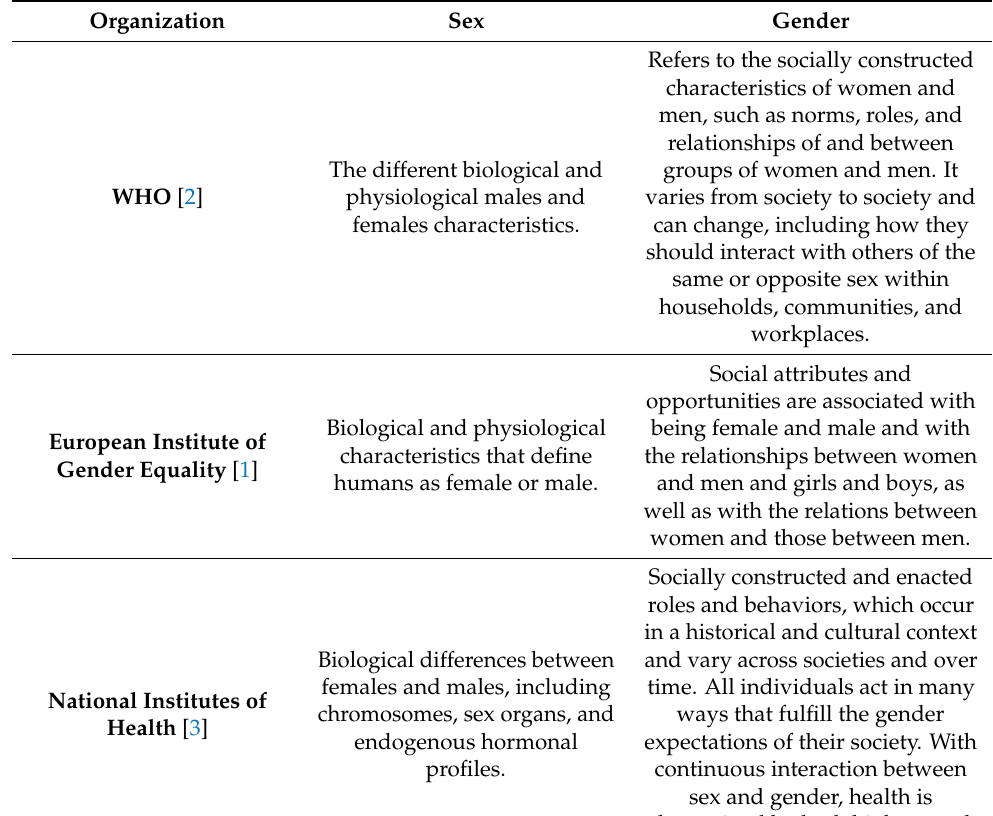
Table 1. Some sex and gender